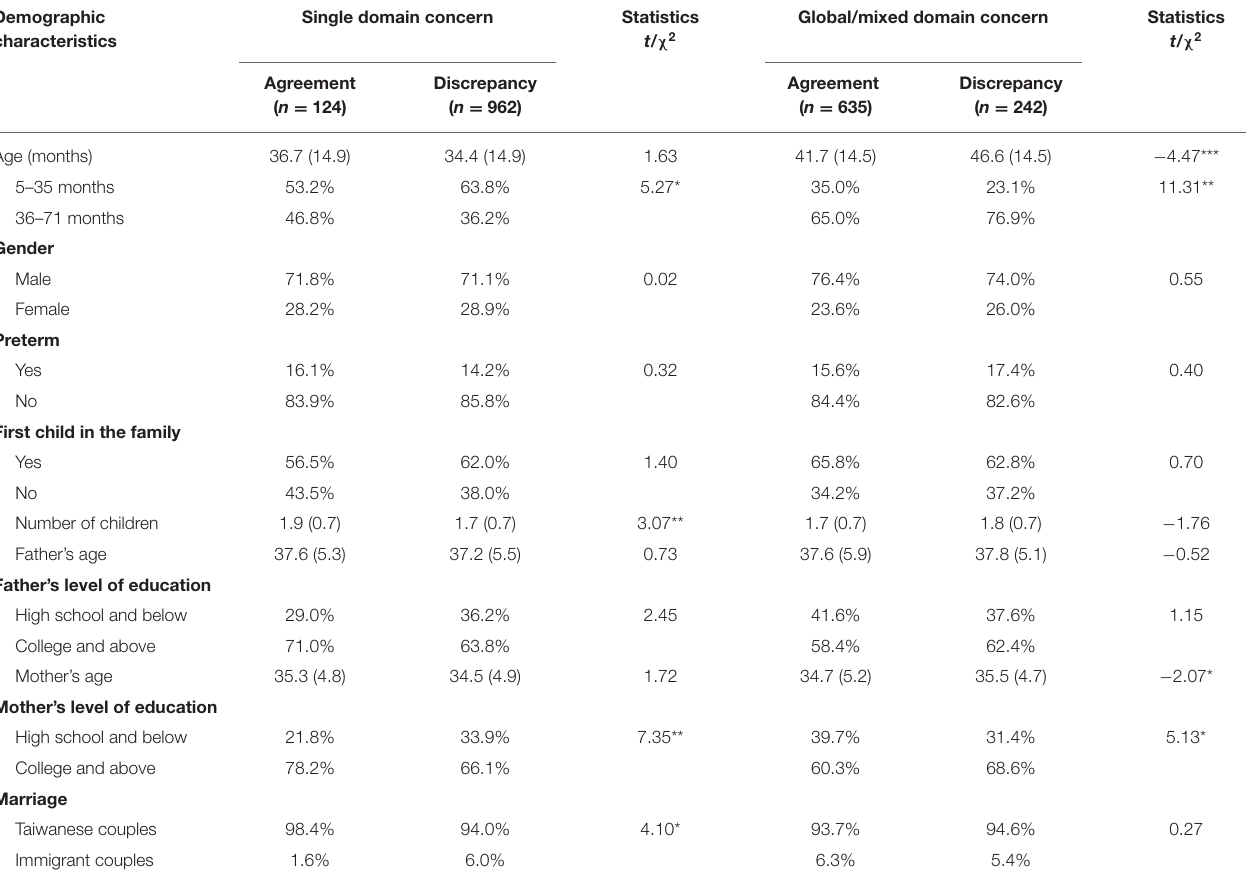
TABLE 5 | The agreement and discrepancy between caregivers’ concerns and professional identification of children’s developmental problems as a function of demographic characteristics. Demographic